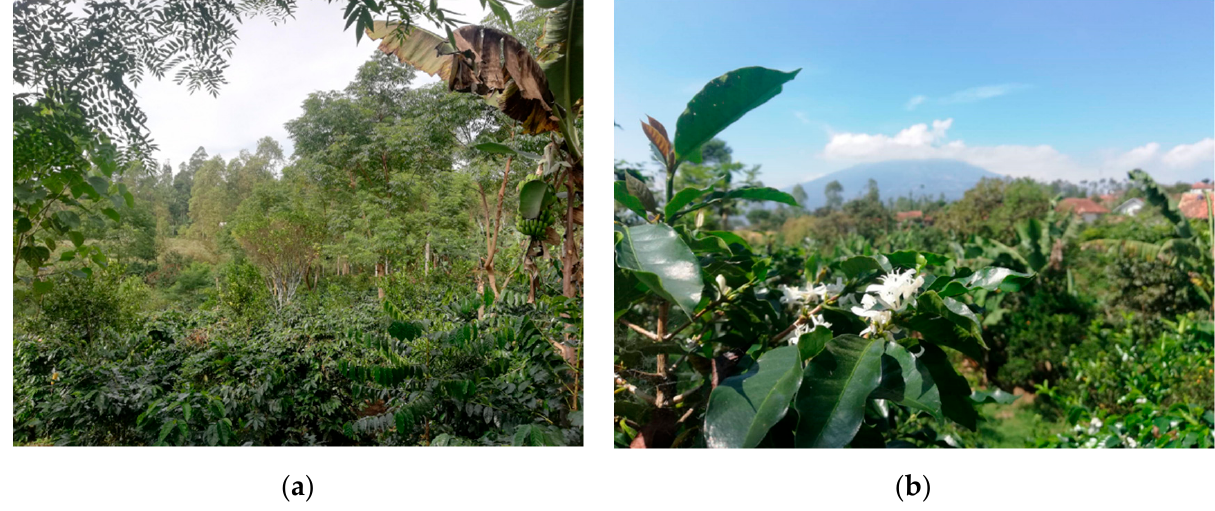
Figure 1. Examples of coffee home gardens that can be found at the study site. ( a ) coffee home garden with partial shade given by multiple tree species; ( b ) coffee home garden with no shade.